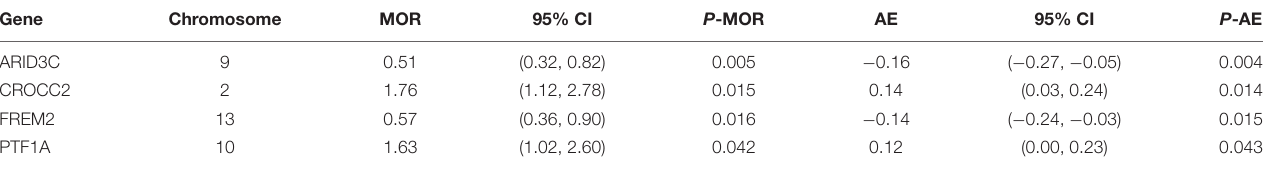
TABLE 3 | Four genes shown significant association after TMLE